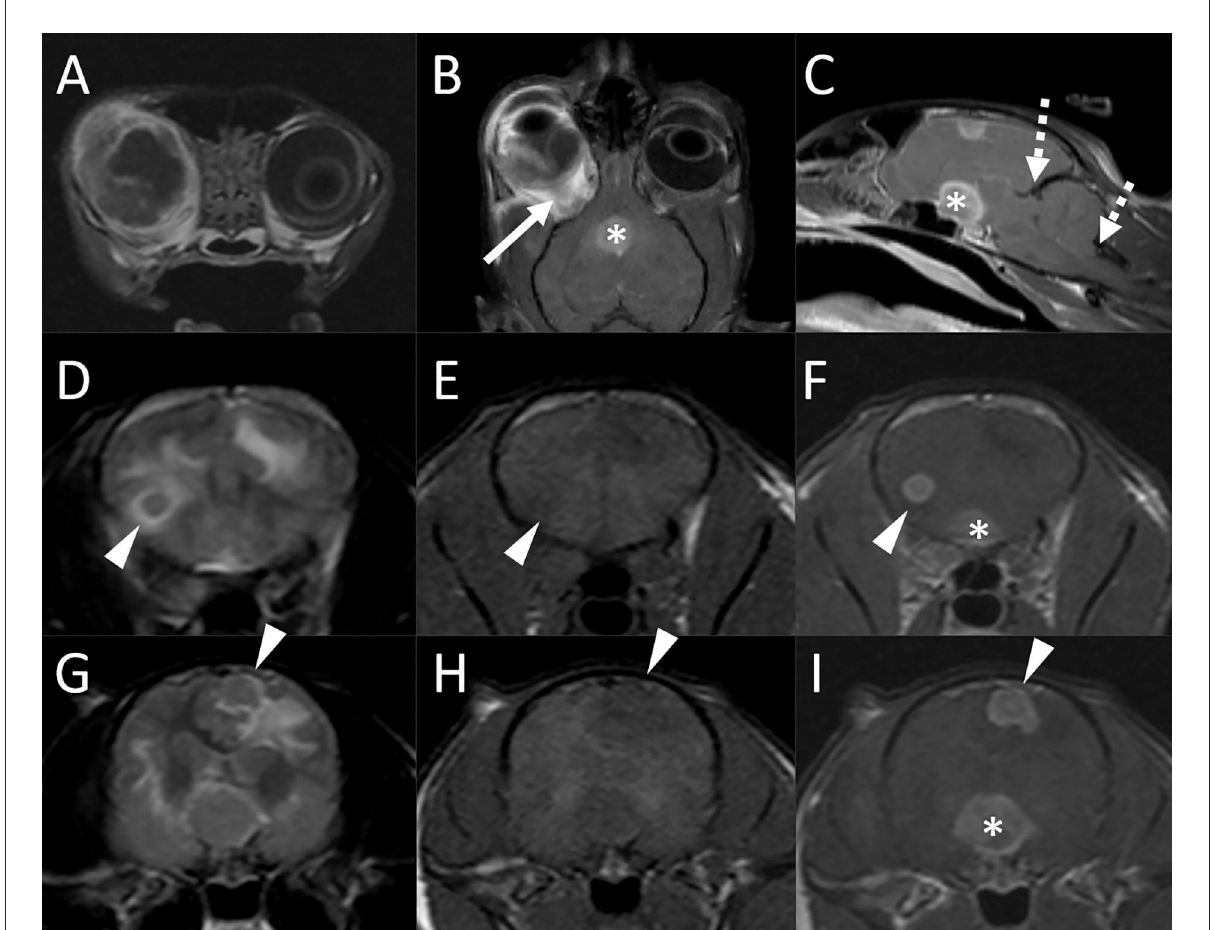
FIGURE3 Brain MRI in a 3-year-old domestic shorthair cat (Case 2) following a diagnosis of ocular blastomycosis and with concern for intracranial involvement. Transverse (A) , dorsal (B) , and midline sagittal (C) postcontrast T1-weighted images; transverse T2-weighted images [ (D) and (G) ], transverse T1-weighted images before [ (E) and (H) ] and after [ (F) and (I) ] contrast medium administration. There is severe thickening, diffuse heterogeneous alteration in signal intensity, abnormal contrast enhancement of the periocular and tissues, thickening and enhancement of the wall of the globe, and retinal detachment [ (A) and (B) ]. There is diffuse thickening of the right optic nerve [ (B) , arrow] and marked enlargement of the optic chiasm [* in (B) , (C) , (F) , and (I) ]. A round 0.5-cm diameter intra-axial nodule is associated with the caudal aspect of the right frontal lobe [arrowheads, (D)–(F) ] and an irregularly shaped ≈ 0.8cm × 0.7cm nodule is associated with the left parietal lobe [ (G)–(I) , arrowheads]. Both lesions are iso- to mildly hypointense to gray matter on both T2 and T1-weighted images [ (D) , (E) , (G) , (H) ]. Bordering the lesions and extending extensively throughout the cerebral white matter bilaterally, there are parenchymal hyperintensities consistent with vasogenic edema. There is evidence of increased intracranial pressure characterized by attenuation of the CSF signal in the cerebral sulci, compression of the lateral ventricles, a mild midline shift, and caudal transtentorial and foramen magnum herniations [ (C) , dashed